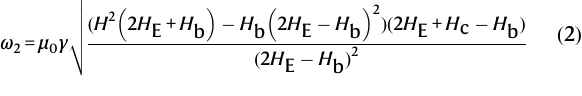
curves along the a , b, and c axes at different temperatures. c The scale-up minor loops along the three directions at 10K, indicating the SF transition. d The sche- matic diagram of the SF transition indicating intralayer spin rotation, interlayer AFM orders and the distribution of anisotropic energy in the ab